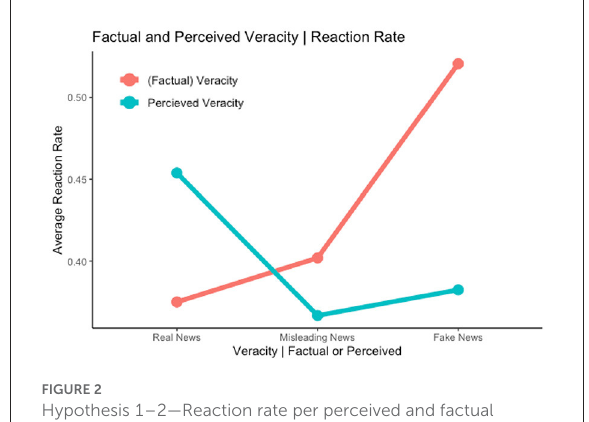
FIGURE2 Hypothesis 1–2—Reaction rate per perceived and factual